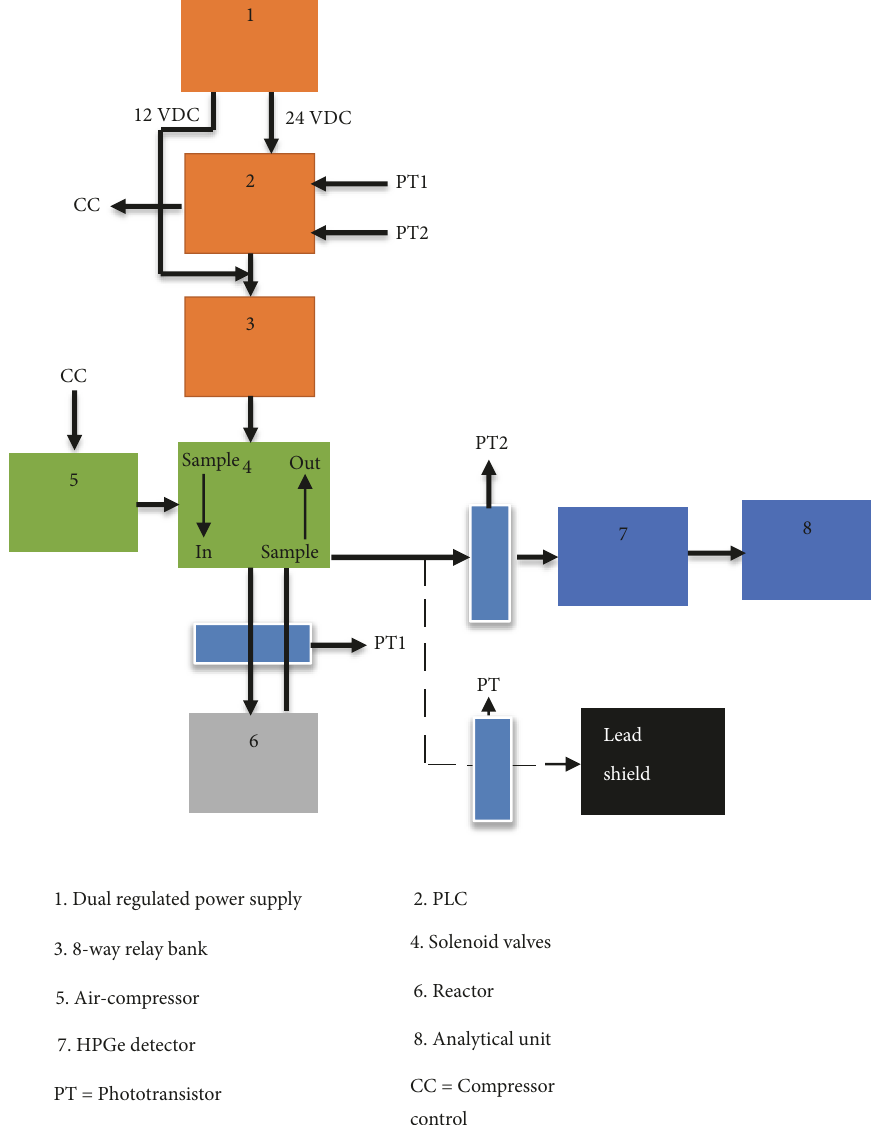
Figure 4: Flow chart for cyclic mode analysis with conventional mode